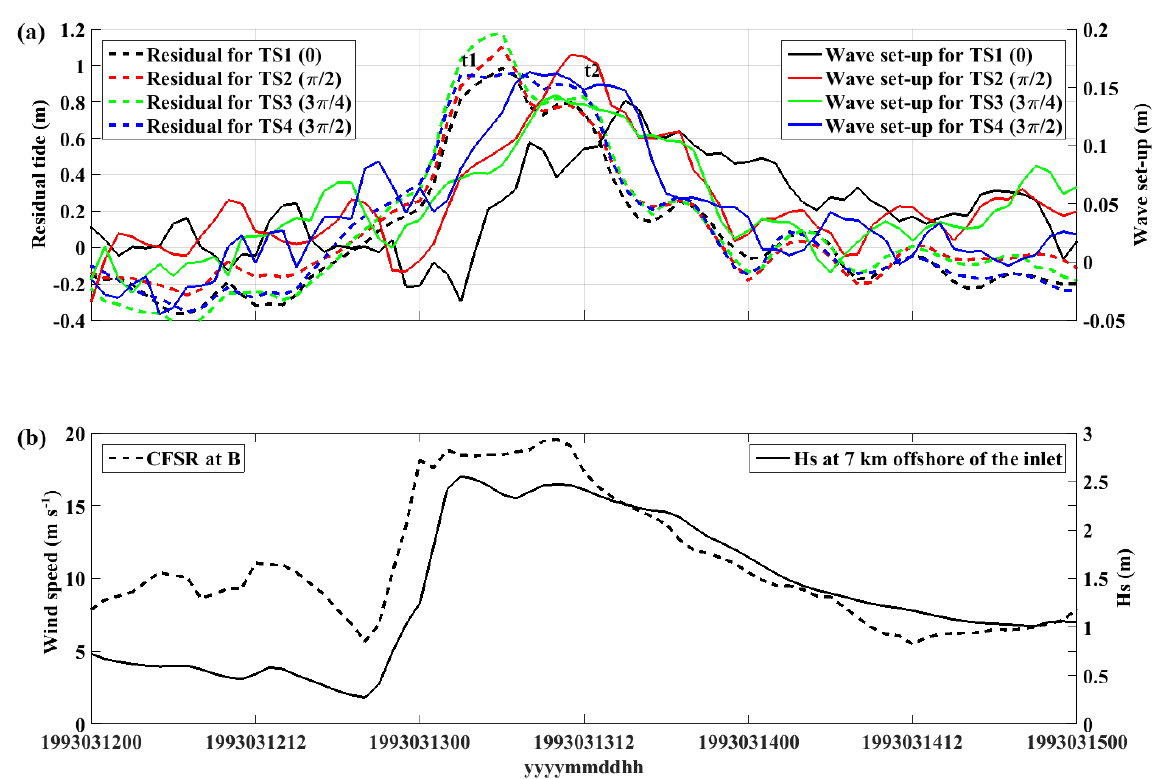
Figure 13. Residual sea level and wave set-up modulated by the tide. (a) Residual sea level and wave set-up for the four tide scenarios. (b) Wind speed at 10ma.m.s.l. and H s used as forcing agents for the numerical experiment with the the HW